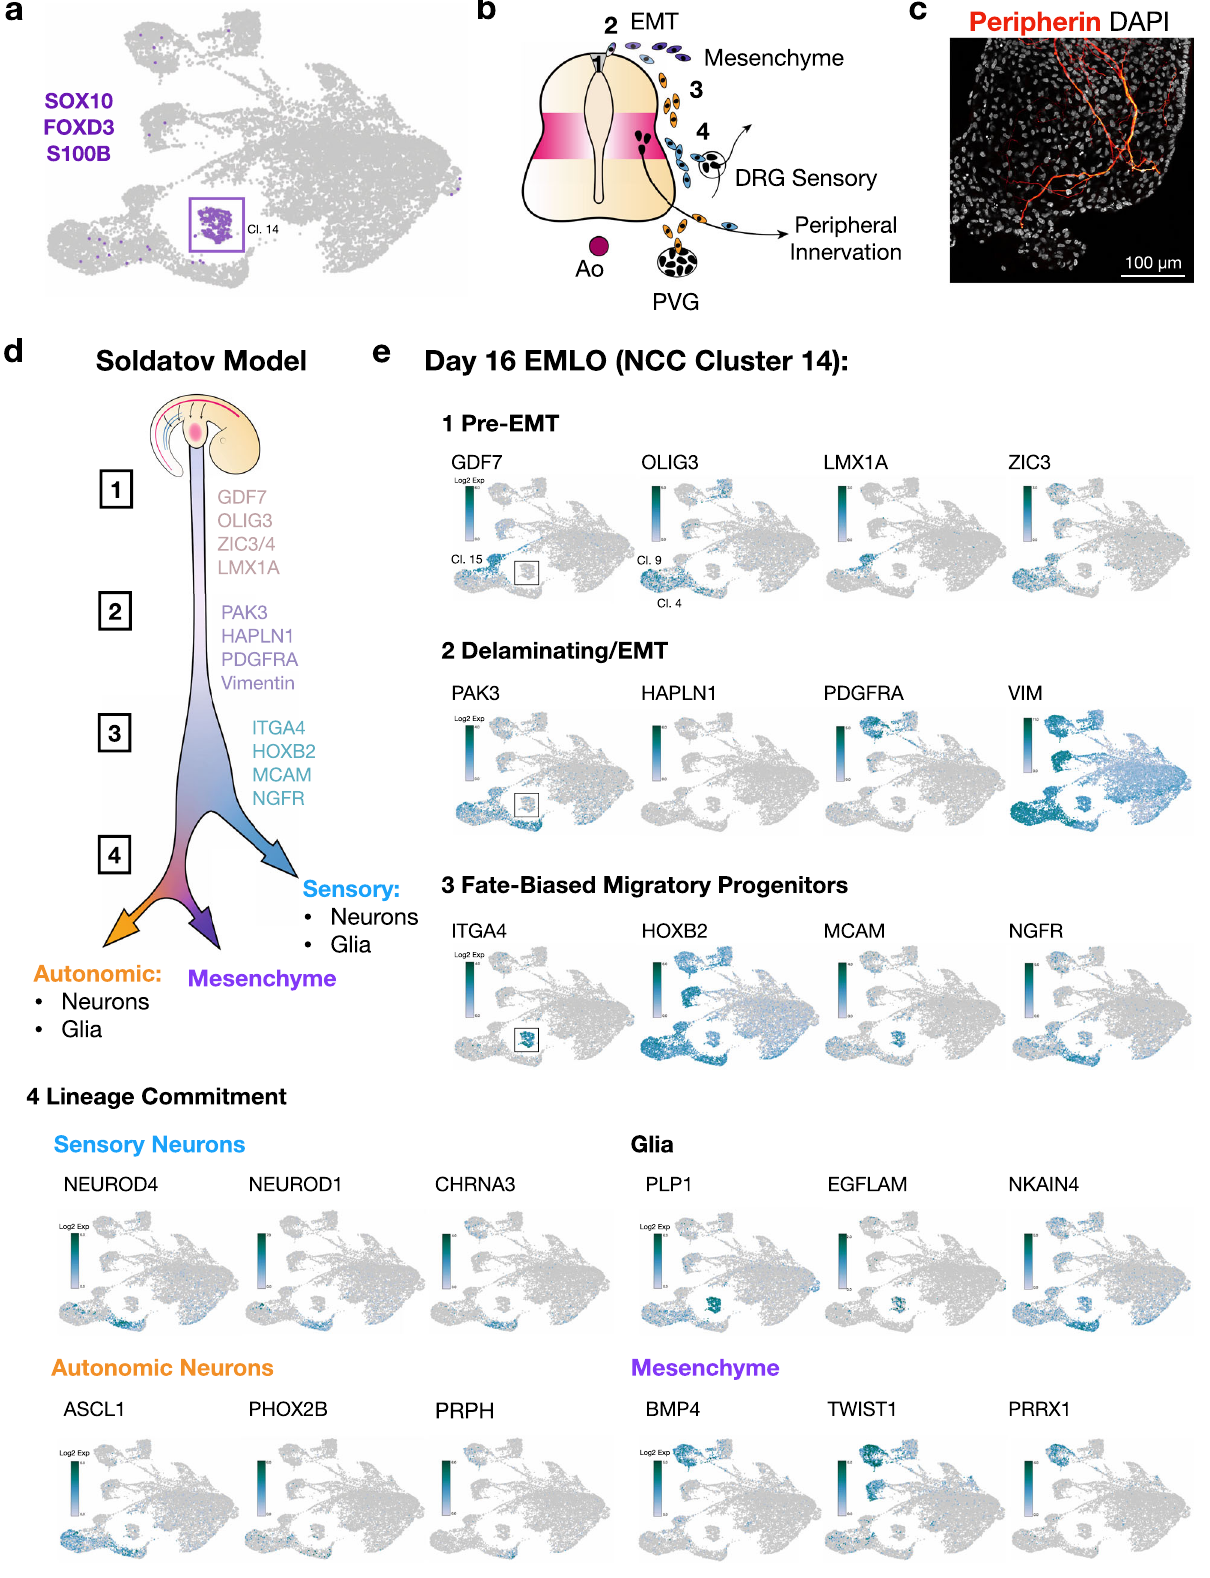
nervous system. The human multi-system EMLO gastruloid is therefore expected to be broadly useful for evaluating neurode- velopmental events impacting early CNS – PNS, endoderm, and neuromuscular co-emergent